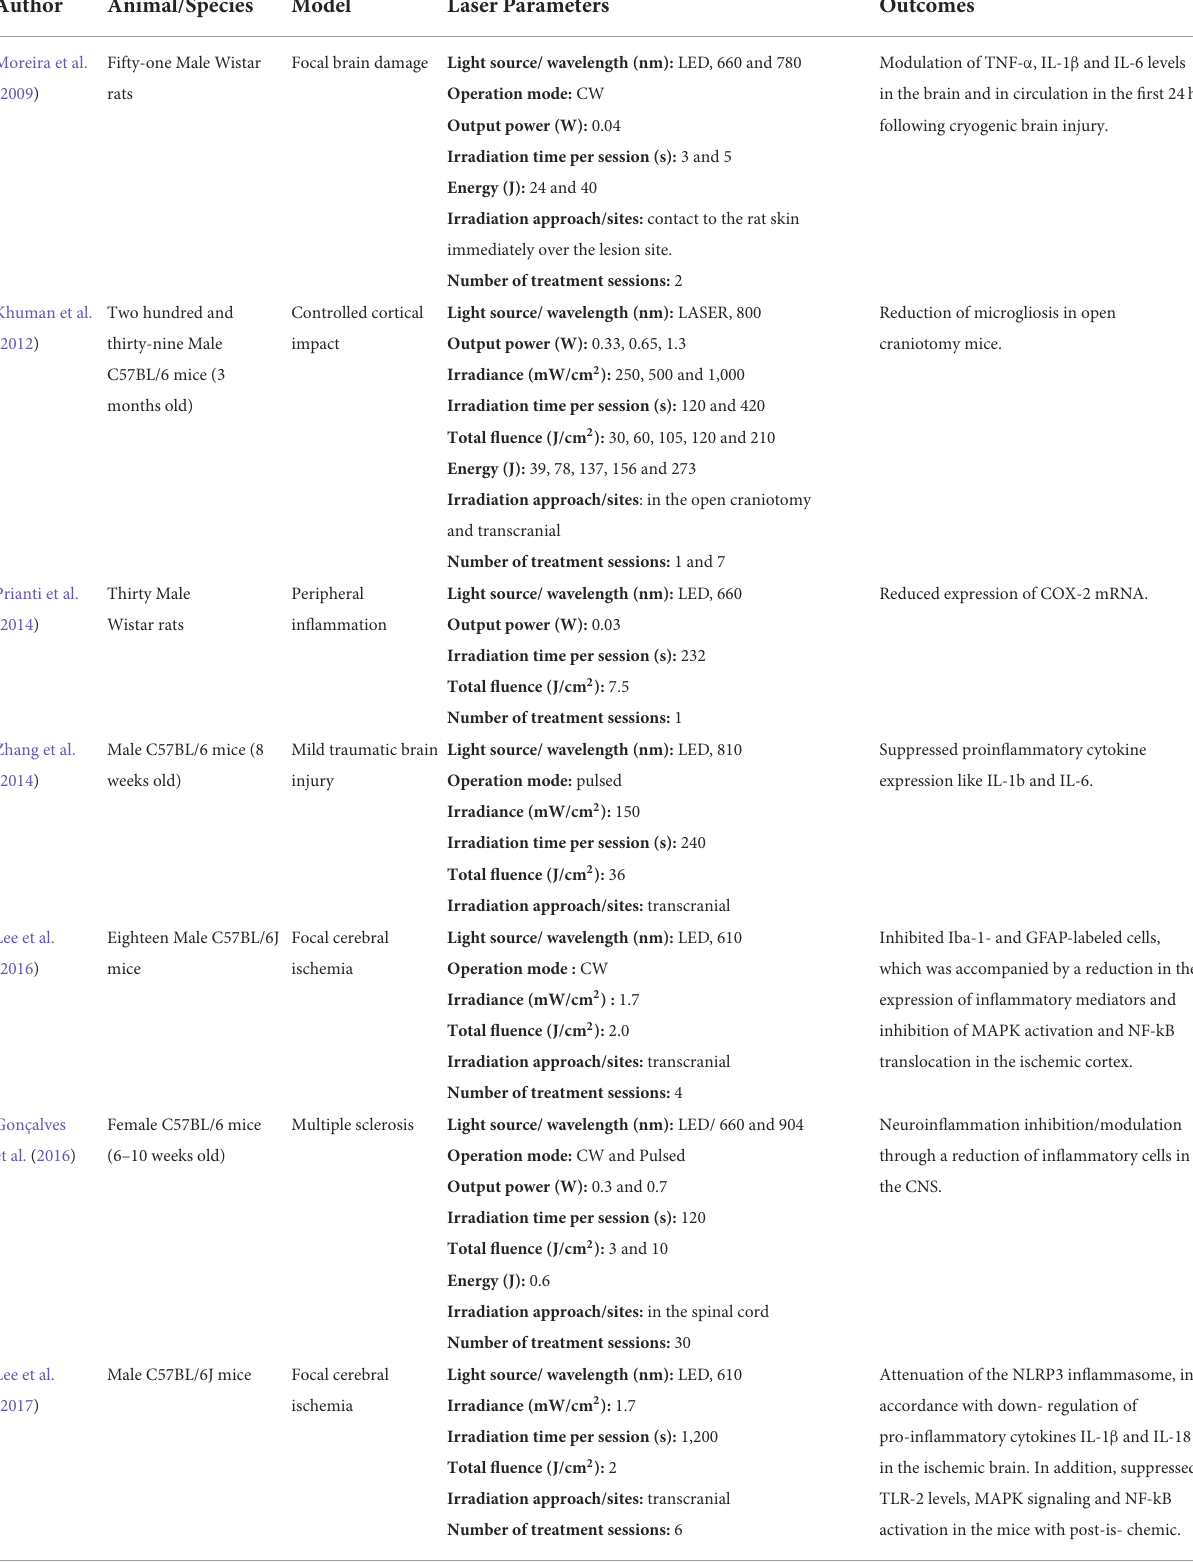
TABLE 2 Summary of laboratory animal studies on neuroinflammatory effects of the